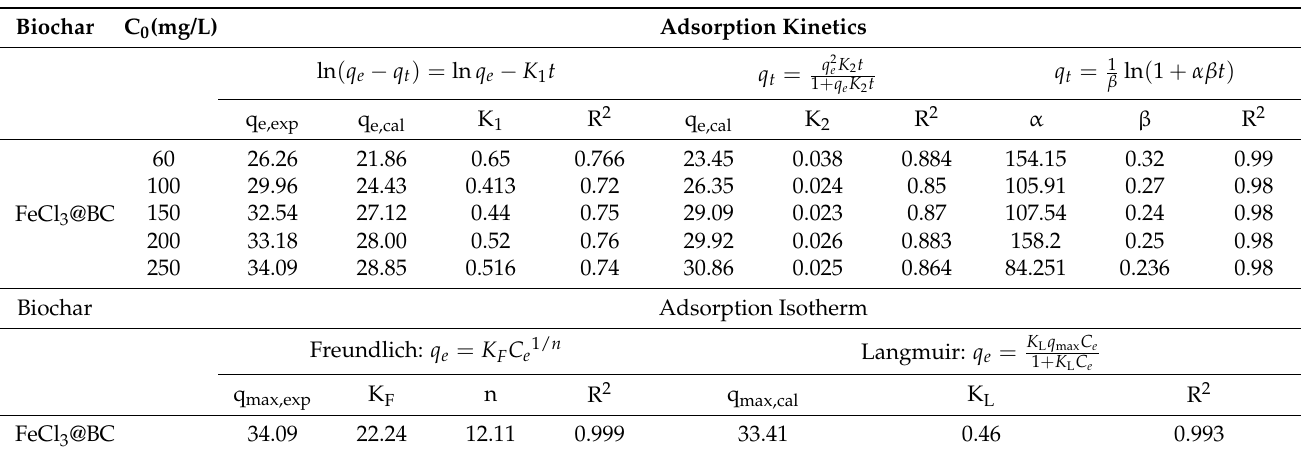
Table 3. Adsorption kinetics and adsorption isotherm